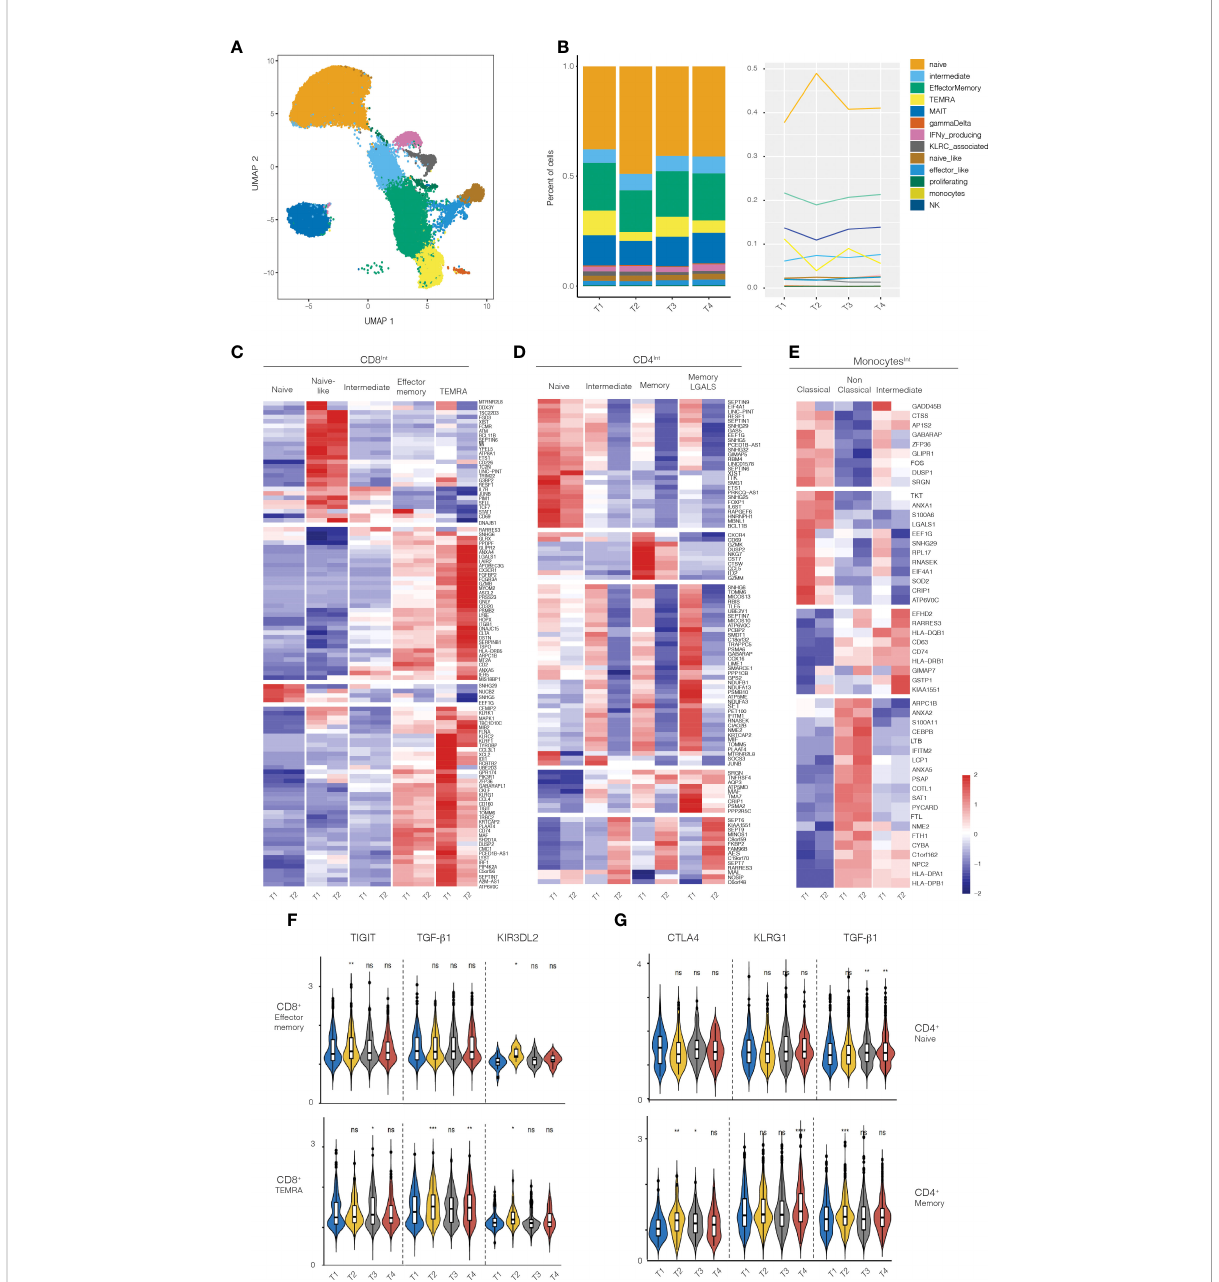
FIGURE 3 RNA-seq analysis on PBMCs from healthy volunteers treated with 50ug of Foralumab. (A) Graphical depiction of the single cell analysis of the CD8+ population isolated from PBMCs showing the cell types that were de fi ned by the clusters based on unbiased DEG the changes in CD8 maturational state subsets derived from the scRNA data in aggregated bar (B) graphs or line graph analyses. (C) Different maturational subsets of CD8 T cells show unique DEG between baseline (T1) and T2. Heatmap presentation of the genes that exhibited increased or decreased expression from baseline after Foralumab treatment. Gene expression values were used to separate the cells into naïve CD8 T cells, naïve-like CD8 T cells (differed from naïve in expression of top group of genes), intermediate CD8 T cells (exhibited features of both naïve and memory cells), effector memory, and TEMRA. (D) Different maturational subsets of CD4 T cells Gene expression values were used to separate the cells into naïve CD4 T cells, intermediate CD4 T cells (exhibited features of both naïve and memory cells), memory CD4, and memory CD4 with strong GALS1 gene expression. (E) Different functional subsets of monocytes. Gene expression values were used to separate the cells into classical, non-classical and intermediate subsets. (F) Violin plots showing changes in expression of TIGIT, TGFb1 and KIR3DL2 in CD8 effector memory and CD8 TEMRA cells. (G) Violin plots showing changes in expression of CTLA4, KLRG1, and TGFb1 in naïve CD4 T cells and memory CD4 T cells. Unpaired two-sided T-test against timepoint 1 (T1vT2, T1vT3, T1vT4) was used to get the posted signi fi cance score if it changed from the baseline. *p<0.05, **p<0.001, ***p<0.0001, ****P<0.0001, ns, not signi fi